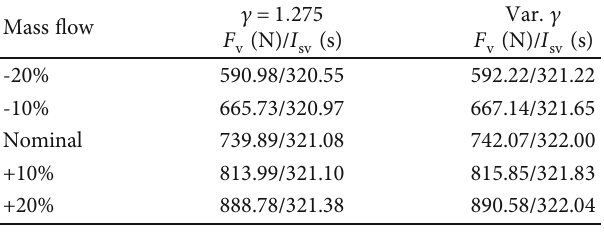
Figure 9: Comparison of Mach numbers in di ff erent nozzles. Table 5: Performance of the nozzle with various extension